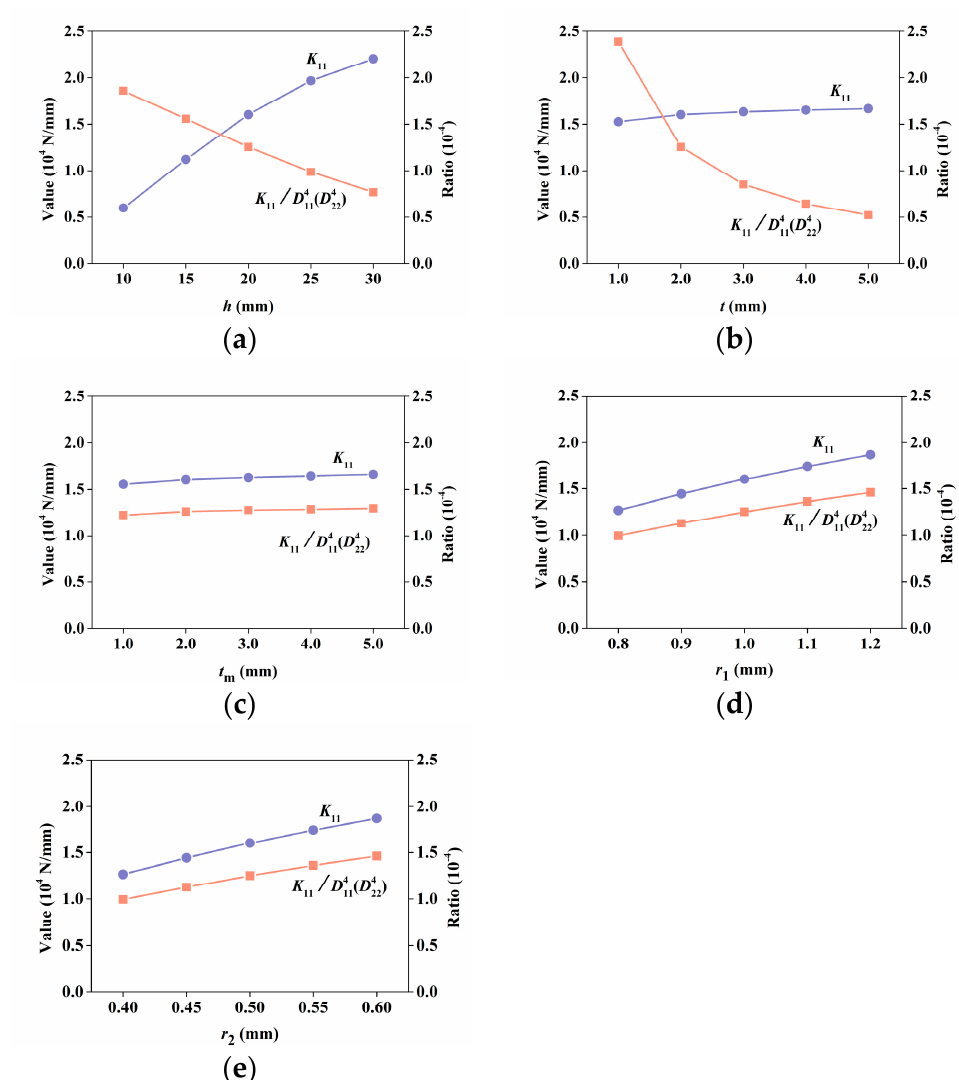
Figure 9. Shear stiffness coefficients in K by S-NIAH and ratio K 11 / D 4 cell parameters ( h , t , t m , r 1 , and r 2 ): ( a ) lattice height h , ( b ) upper and lower bound plate thickness t , ( c ) inner plate thickness t m , ( d ) radii of robs in spare layer r 1 , and ( e ) radii of robs in dense layer r 2 .